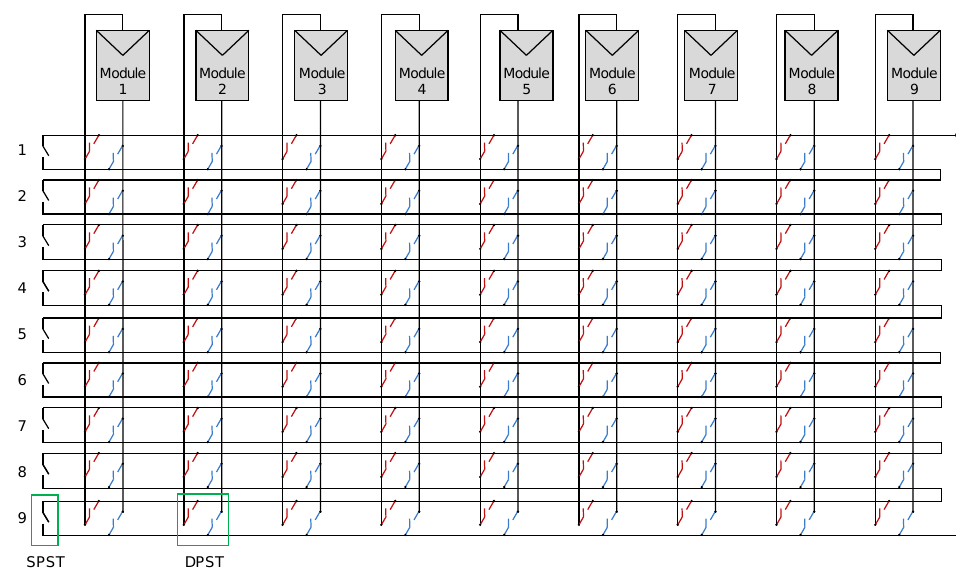
Figure 8. Dynamic Electrical Scheme. Reprinted/adapted with permission from Ref. [21]. 2013, Romano et